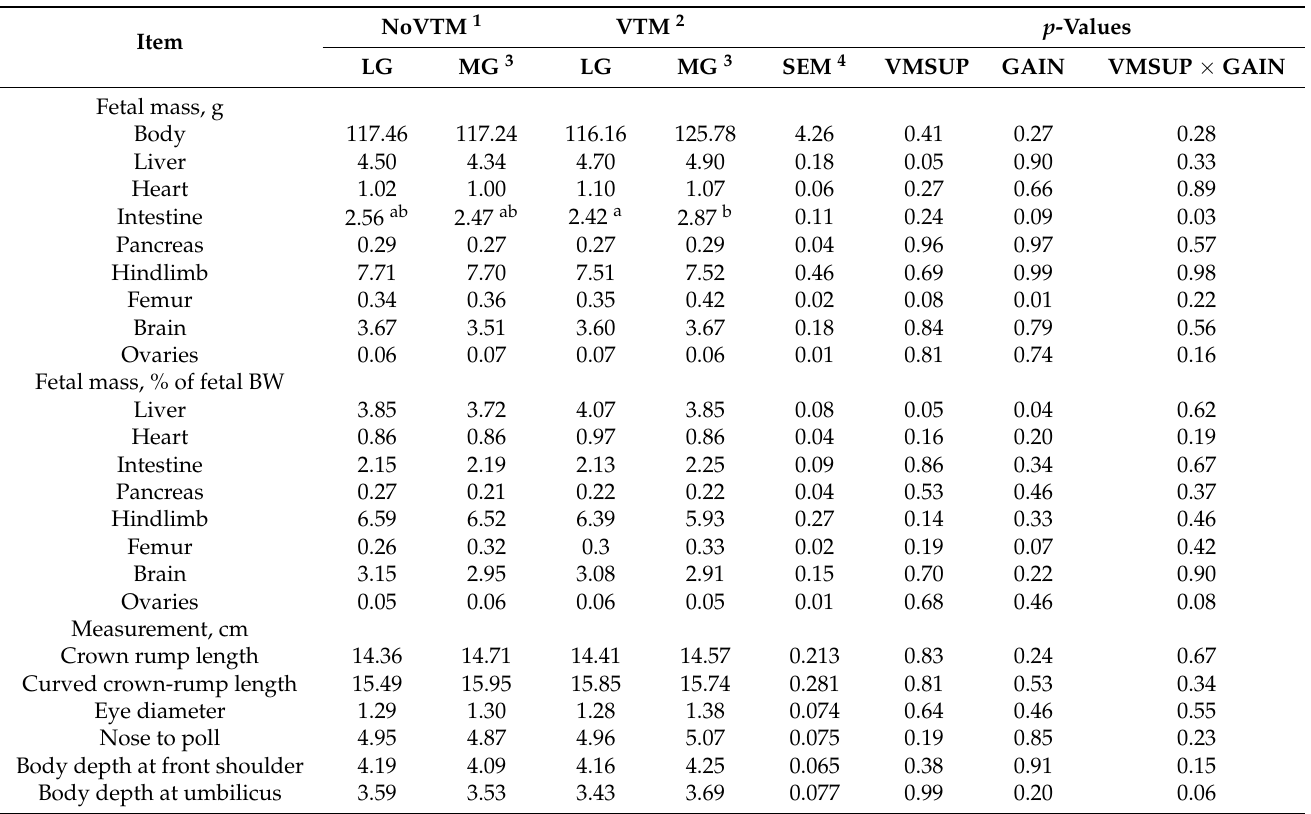
added vitamin and mineral supplement. 2 VTM: Vitamin mineral supplement was a pelleted product fed at a 0.45 kg • heifer − 1 • day − 1 (consisting of 113 g of a vitamin and mineral supplement, formulated to deliver similar levels of vitamins and minerals that were fed pre-breeding and 337 g of a carrier). 3 Heifers fed a pelleted blend of ground corn, dried distillers grains plus solubles, wheat midds, fish oil, urea, and ethoxyquin fed at rate to achieve targeted gain of 0.79 kg/d. 4 NoVTM-LG ( n = 9); NoVTM-MG ( n = 9); VTM-LG ( n = 9); VTM-MG ( n = 8). 5 Mean diameter of 3 largest placentomes in the reproductive tract. Table 7. Effect of feeding a vitamin and mineral supplement [VMSUP; not supplemented (NoVTM) or supplemented (VTM)] and two different rates of gain [GAIN; low rate, 0.28 kg/d (LG) or moderate rate, 0.79 kg/d (MG)] to beef heifers during the first trimester of gestation on fetal and fetal organ mass and fetal body measurements at d 83 ± 0.27 of